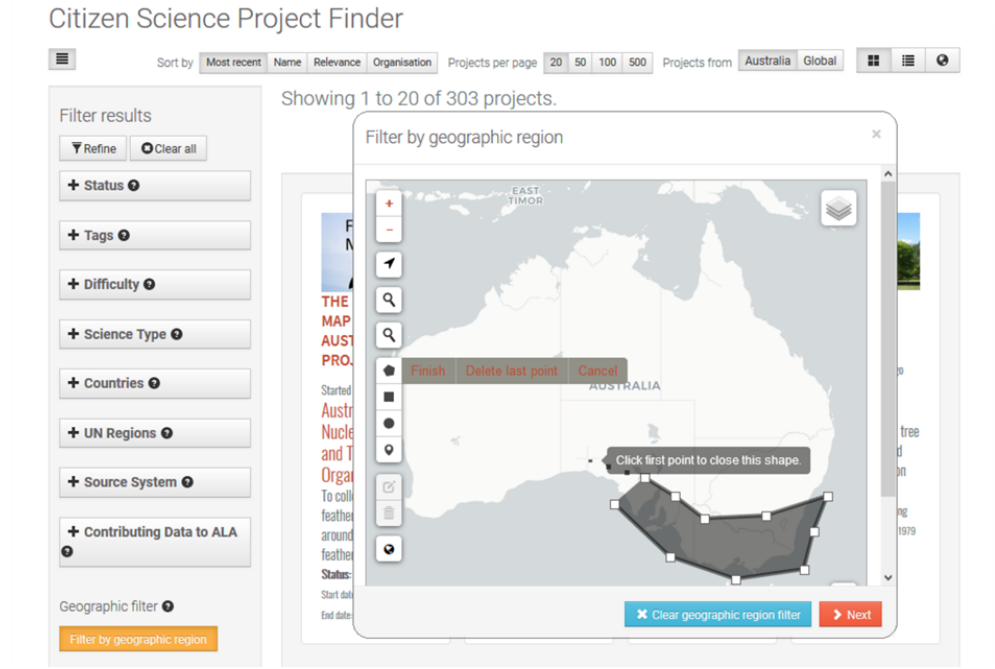
Figure 4. A view of the Citizen Science Project Finder interface implemented in The Atlas of Living Australia